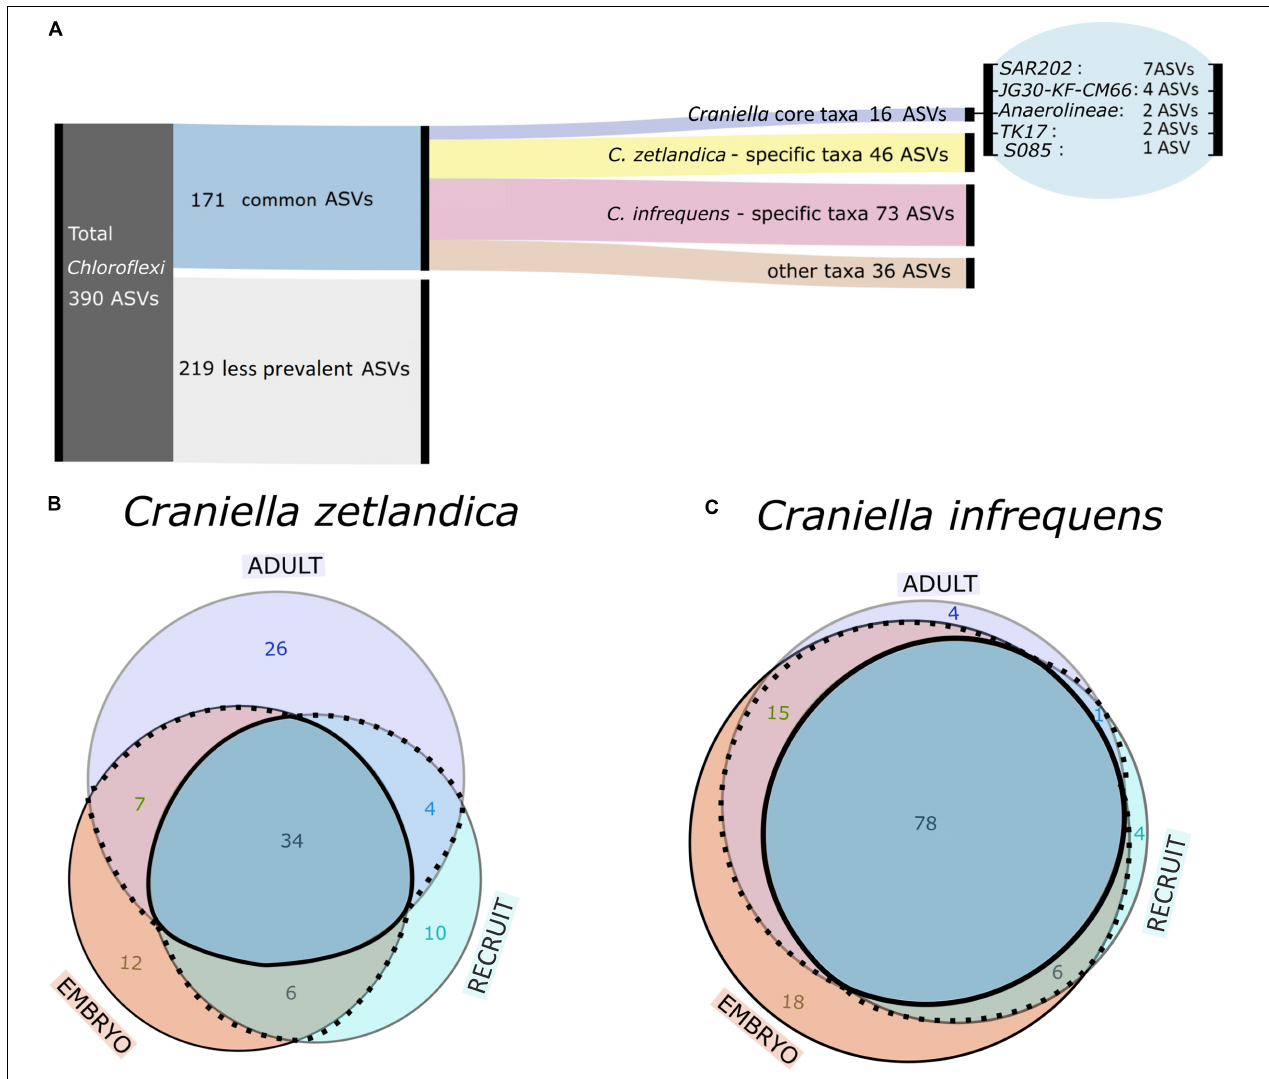
FIGURE 6 | (A) Alluvial diagram showing grouping scheme of Chloroflexi ASVs. (B,C) Area proportional Venn-diagram showing counts of common Chloroflexi ASVs being shared or specific across different life stages for (B) C . zetlandica and (C) C . infrequens